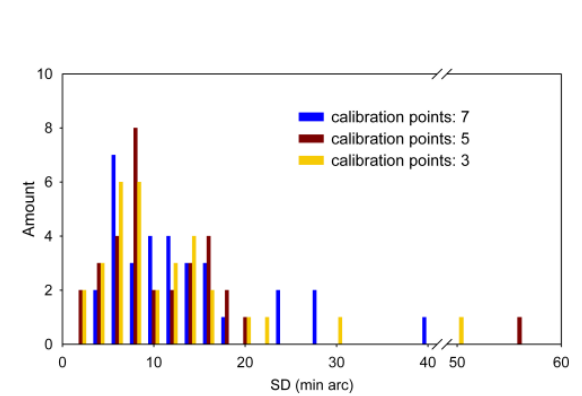
Figure 6: R² distribution for empirical calibrations with 3, 5 and 7 calibration points at constant inter-point separations of 90 min